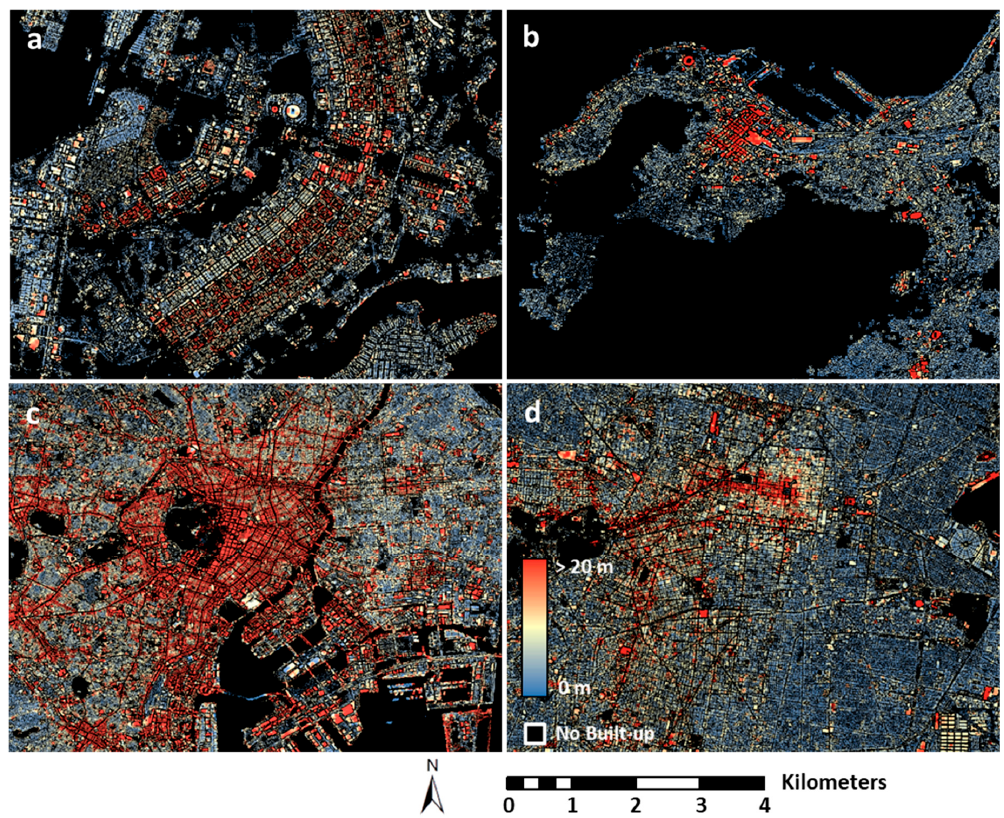
Figure 8. Examples of the GUF-3D layer derived for several globally distributed city regions such as Brasilia ( a ), Cape Town ( b ), Tokyo ( c ), and Mexico City ( d ).